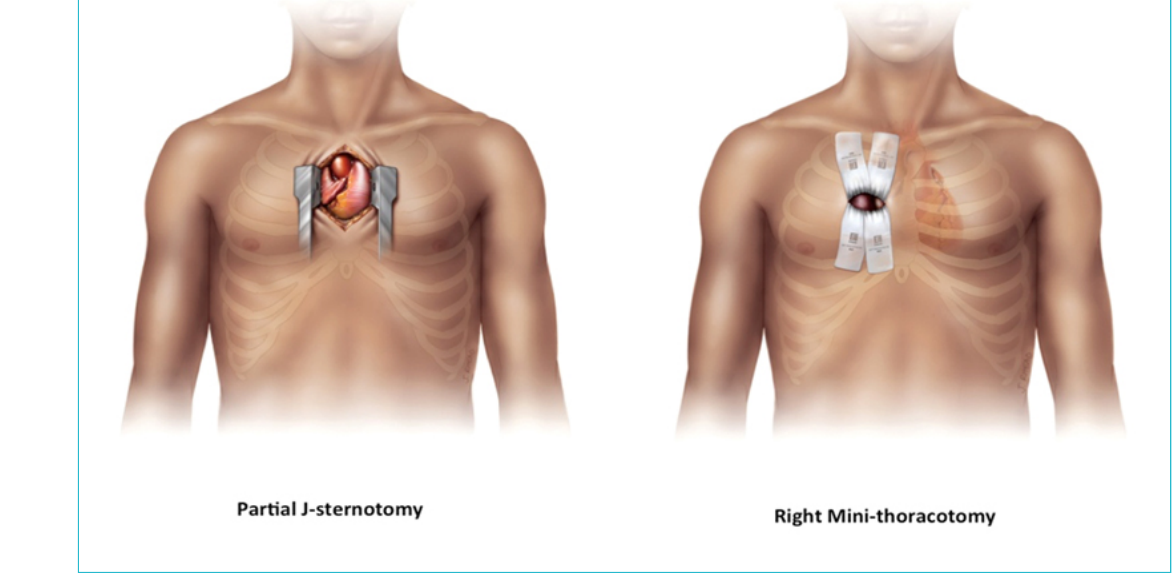
Figure 1: Demonstration of the two most common approaches through ministernotomy (image courtesy of Edwards Lifesciences